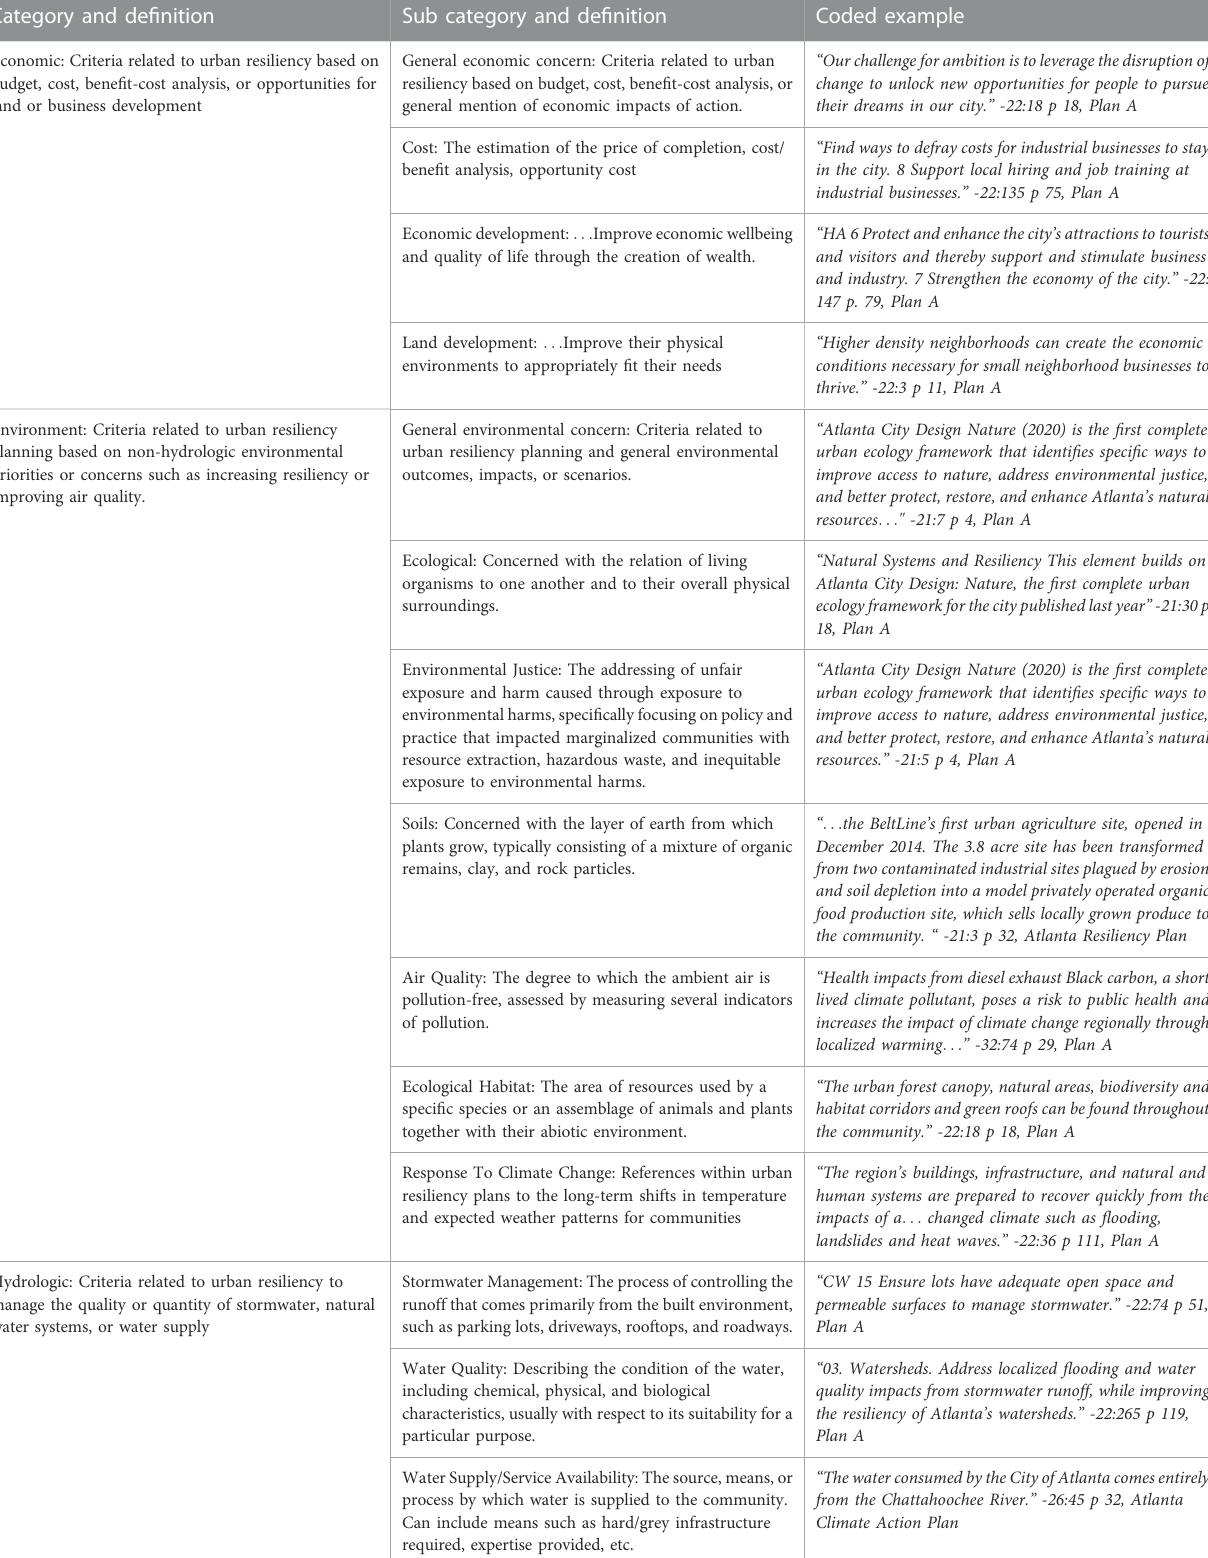
TABLE 1 Comprehensive list of coding: categories, sub categories, de fi nitions, and examples of each from selected documents. Category and de fi nition Economic: Criteria related to urban resiliency based on budget, cost, bene fi t-cost analysis, or opportunities